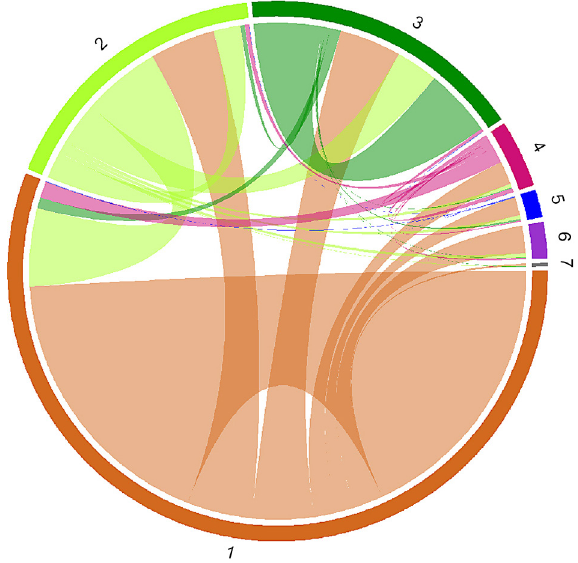
Fig. 5. Land use transitions in the Adamów-Koźmin